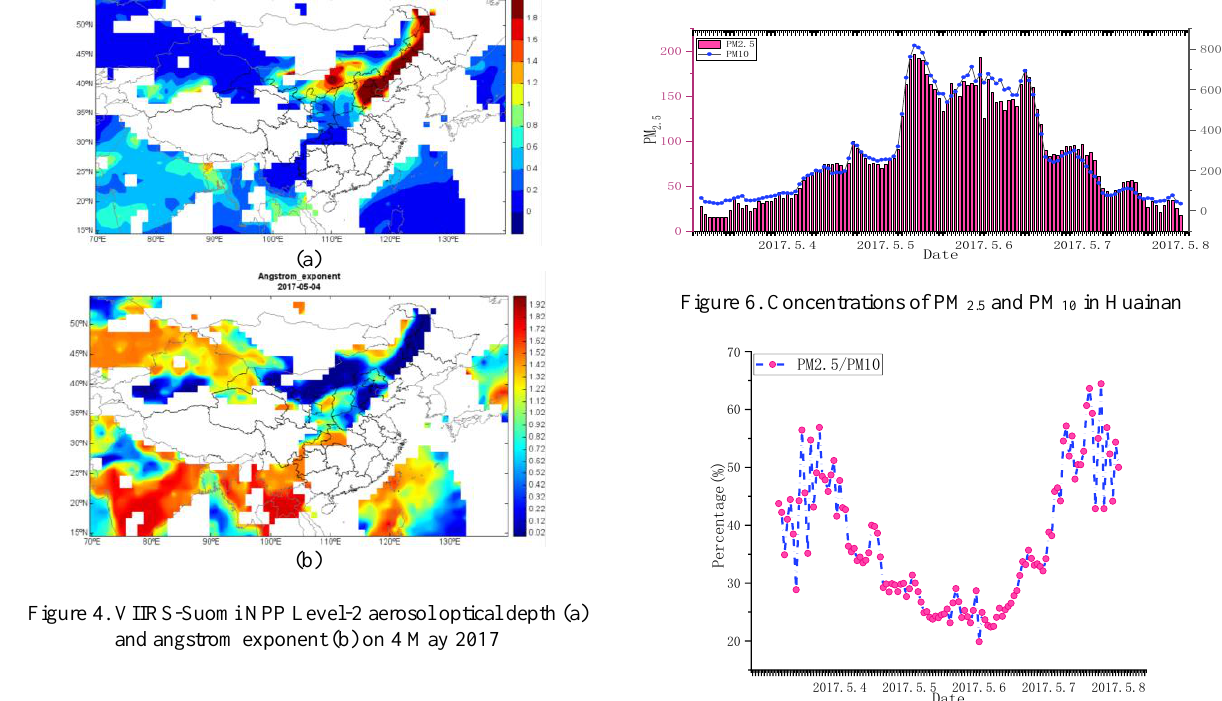
Figure 5. HYSPLIT 24-h backward trajectories: (a) at the low altitude of 1km, air mass from the Taklamakan Desert; (b) at the high altitude of 4km, air mass from the Gobi Desert 3.2 The Particulate Matter Concentration Impacts on the Air Quality The concentrations of PM 2.5 and PM 10 and the concentration ratio of PM 2.5 to PM 10 are given in Figure 6 and Figure 7, respectively. PM 10 and PM 2.5 have good synchronicity. The hourly average change of PM 10 is from 36μg/m 3 to 818μg /m 3 , while the hourly average change of PM 2.5 is from 15μg/m 3 to 197μg/m 3 . Beginning in the early morning of May 5, PM 2.5 and PM 10 began to increase gradually, but as can be seen from Figure 6, the ratio of PM 2.5 to PM 10 became smaller after the start of dust weather, indicating that the weather was in the process of pollution ， the dust has become a major pollutant. On the afternoon of May 6, the concentration of particulate matter gradually decreased, and the ratio of the two also gradually increased. On May 8, the particulate matter concentration dropped to the lowest value and the dust weather ended.